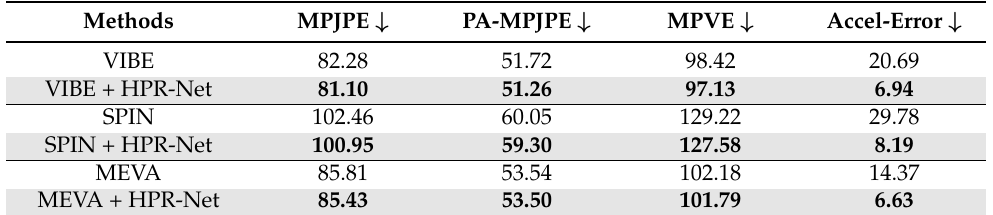
Table 5. HPR-Net’s pose refinement performance for various existing methods on 3DPW test data. Bold values indicate performance improvements.